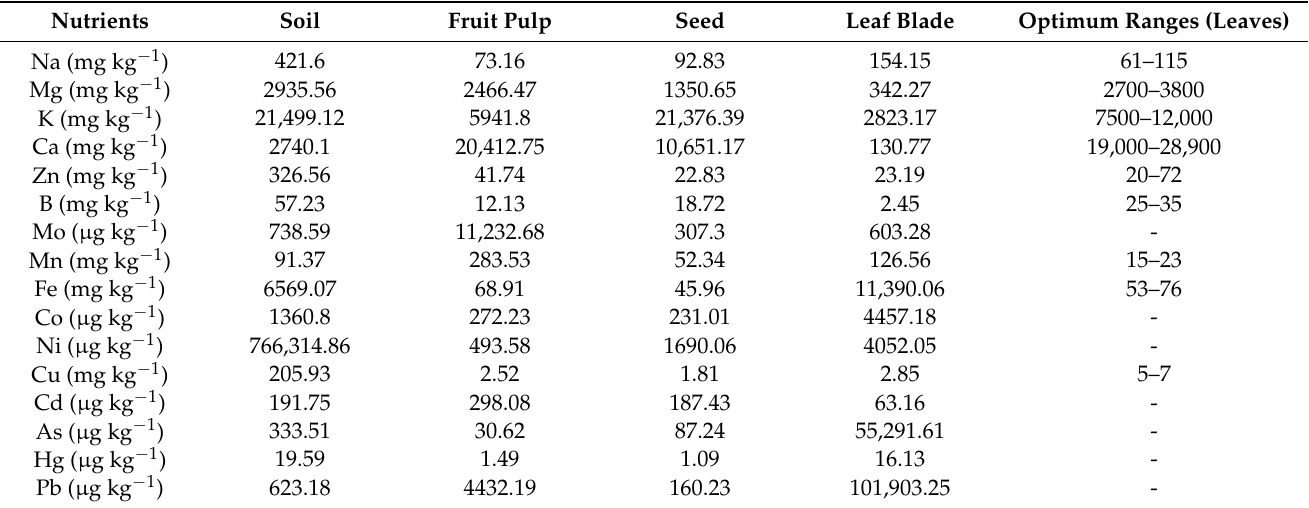
Table 1. Mineral nutrients and heavy metal concentrations in loquat soil and plant tissues determined before the foliar application of Mg, Zn, and